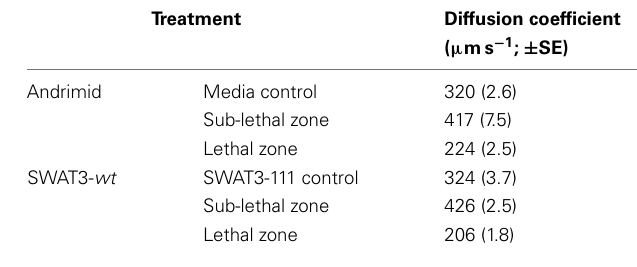
Table 2 | Calculated diffusion coefficients ( ± 1 compounded standard error of the mean, SE) for V. cholerae.